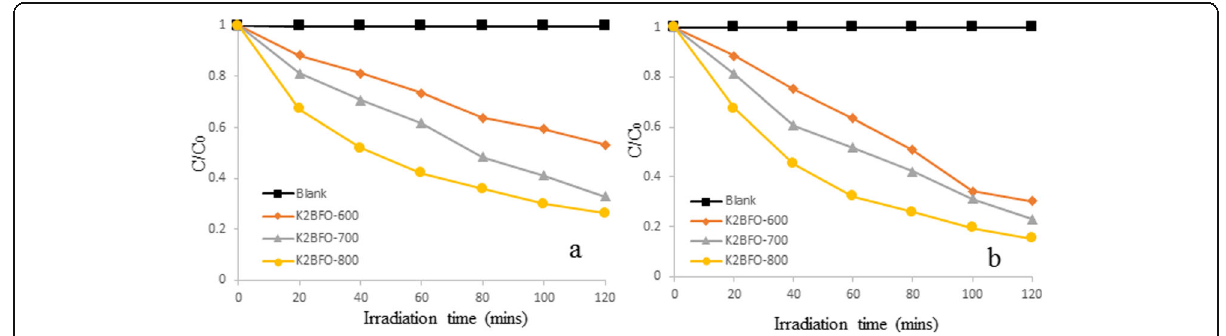
Fig. 4 MB photodegradation of K2BFO 600 – 800° C (a) in the absence of peroxide (b) in